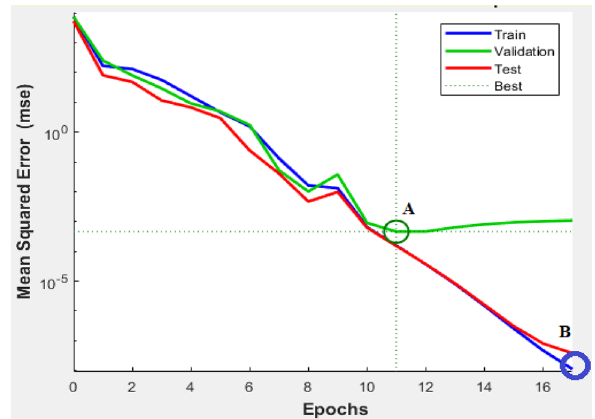
Figure 4. Early stopping to avoid overfitting.